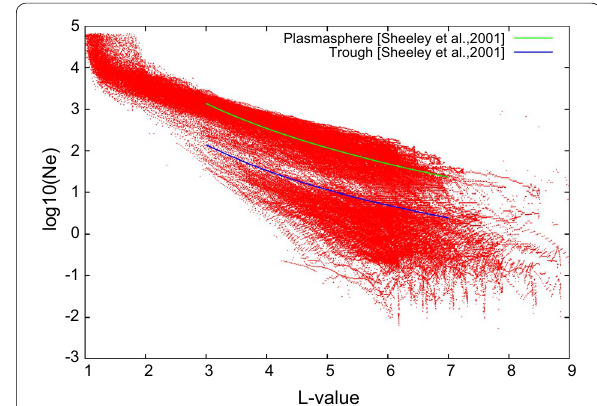
Fig. 9 Electron number density obtained from January to July 2017 (red). Green and blue curves, respectively, indicate the empirical profiles of electron number densities in the plasmasphere and trough regions, as reported by Sheeley et al.